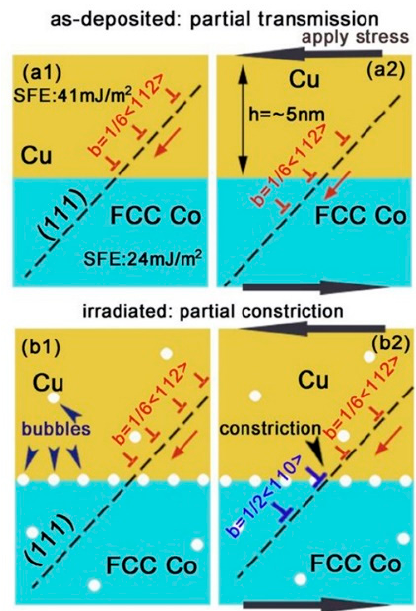
Figure 20. Hypothetical schematics compare strengthening mechanisms in as-deposited and irradiated Cu/Co (100) multilayers at small h (h = 5 nm). ( a1, a2 ) In as-deposited films, partials can trespass layer interfaces owing to the low stacking fault energy of Cu and Co. ( b1, b2 ) However, after radiation, bubbles at the layer interface disrupt the transmission of partials [56].